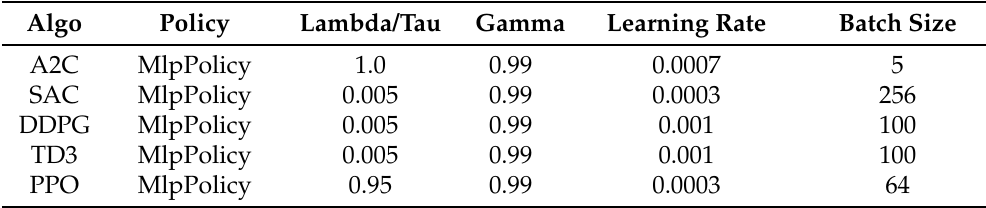
Table A1. Default RL agent’s